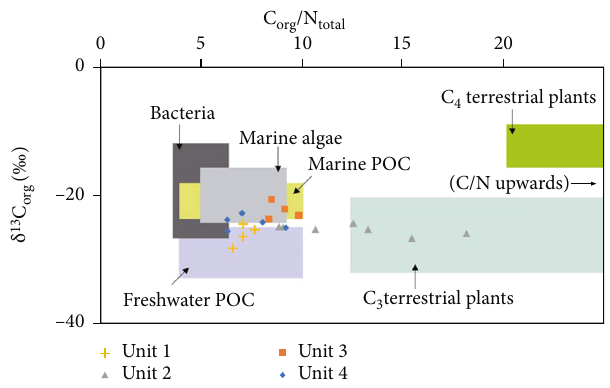
Figure 6: δ 13 C 973-4. Data fi elds after Lamb et al.